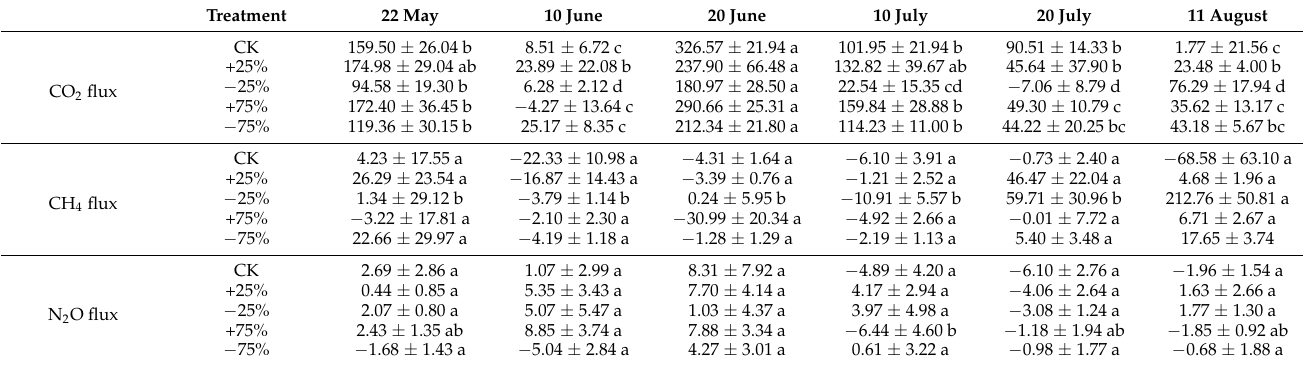
Table 1. Multiple comparisons of the CO 2 , CH 4 , and N 2 O fluxes treated by five types of rainfall in the Niaodao Lakeside